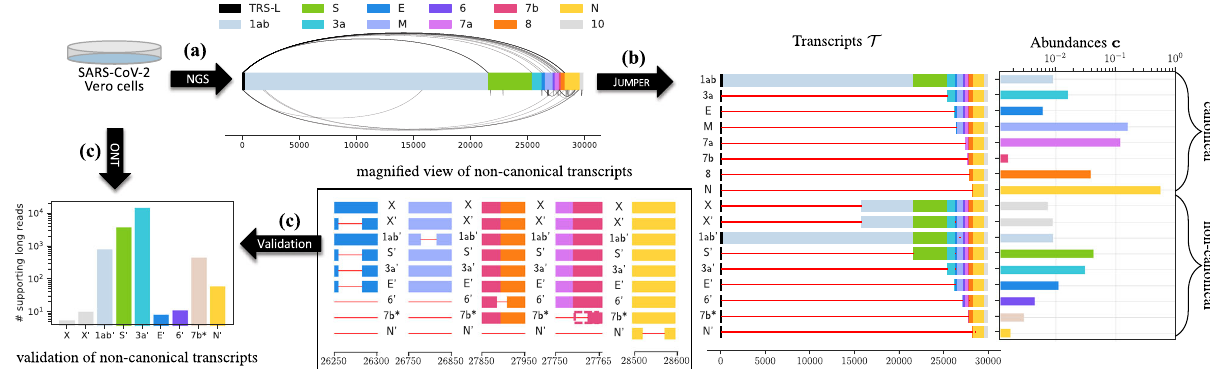
Fig. 4 Using short-read data of SARS-CoV-2-infected Vero cells 3 , JUMPER identi fi es canonical and non-canonical transcripts that are well supported by long-read sequences of the same sample. a The segment graph for the short-read data contains both canonical (above) and non-canonical (below) edges. b JUMPER assembles eight canonical transcripts and nine non-canonical transcripts and estimates their abundances with zoomed-in view of the non-canonical transcripts X, X', 1ab', S', 3a', E', 6', 7b*, and N'. c All non-canonical transcripts predicted by JUMPER are well supported by long-read data. NGS next-generation sequencing, ONT Oxford Nanopore